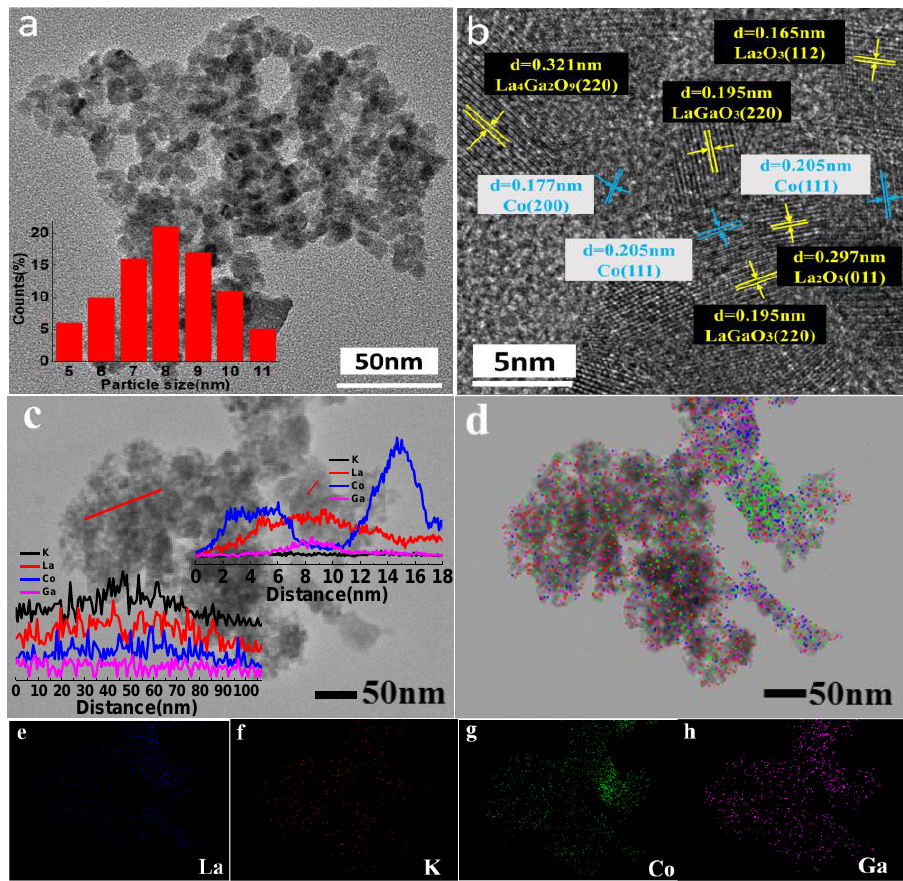
Figure 5. Transmission electron microscopy (TEM) images ( a – c ), line scanning profiles, energy dispersive spectrometer (EDS) mapping image ( d ), and the elements distribution of La ( e ), K ( f ), Co ( g ), and Ga ( h ) for the reduced LKCG-0.1.